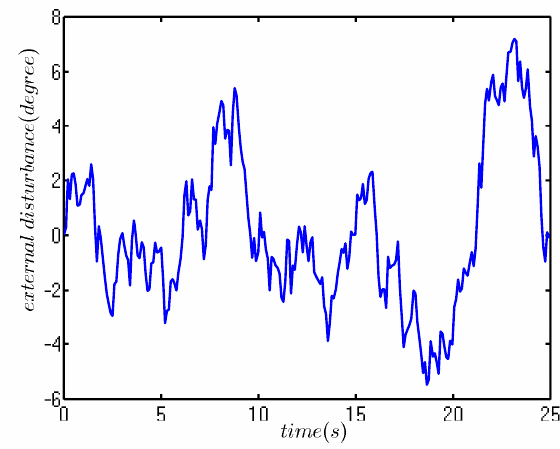
Figure 11. External disturbance curve.